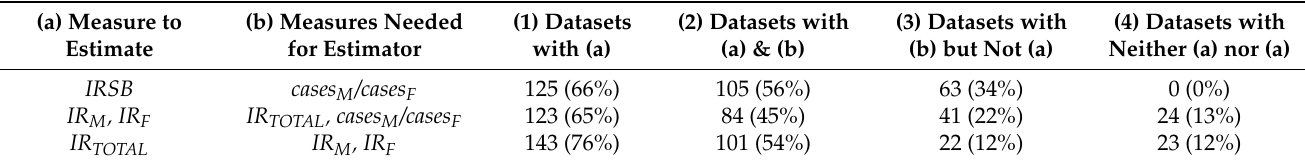
Table 1. Measures to estimate, measures needed for estimators, and numbers of datasets with values for these measures. Numbers indicate dataset count and percentage (out of 188 total datasets) for each group of datasets (1–4) described in the